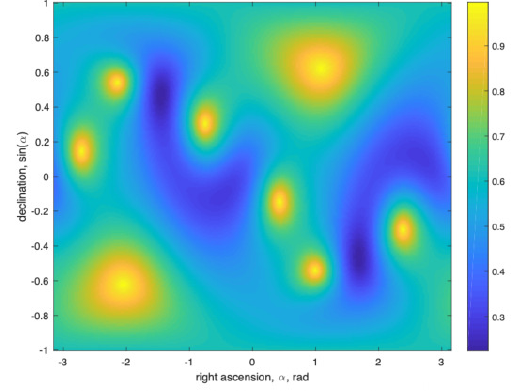
Figure 6. Ratio F N × / F N + for EAN in DPF for the optimal